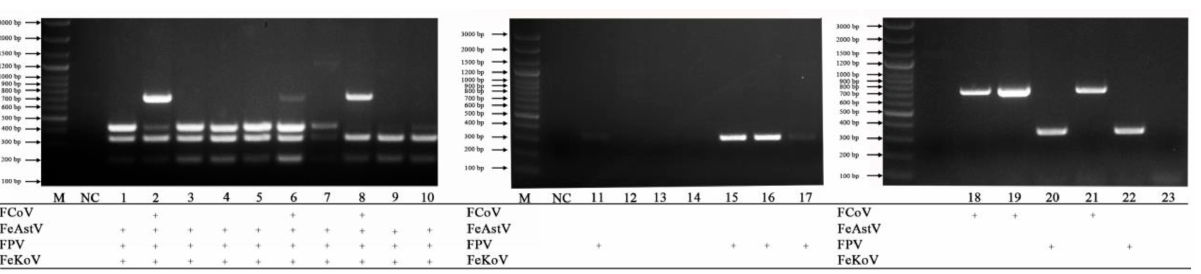
Figure 5. Examination of anal clinical samples. Lane M, DNA marker (100 bp ladder plus); lane NC, negative control; lanes 1–23, anal swab clinical samples.